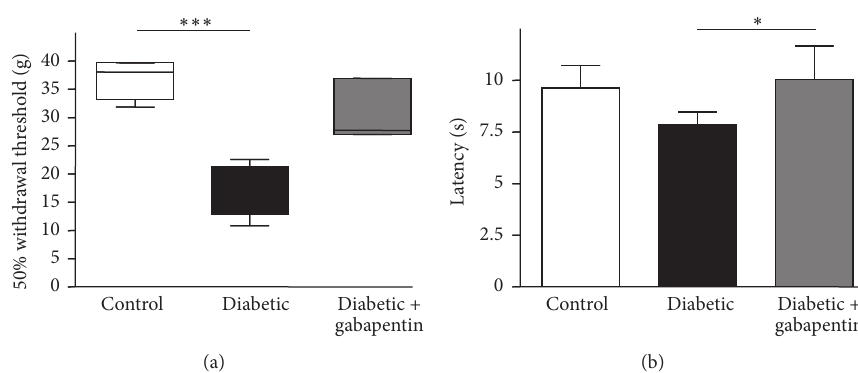
Figure 1: Gabapentin corrects diabetes-induced hypersensitivity. (a) Mechanical allodynia was observed in untreated diabetic rats (8 weeks after STZ), whilst diabetic rats treated with gabapentin showed near-control thresholds. Data are displayed as box and whisker plots, ∗∗∗ 𝑝 < 0.001 , in a Kruskal-Wallis test with Dunn’s post hoc tests. (b) Thermal hyperalgesia was determined using a Hargreaves device; again diabetic rats treated with gabapentin showed near-control thresholds ∗ 𝑝 < 0.05 , in a 1-way ANOVA with Bonferroni post hoc tests. Data represent mean latency + SD; 𝑛 = 6 .